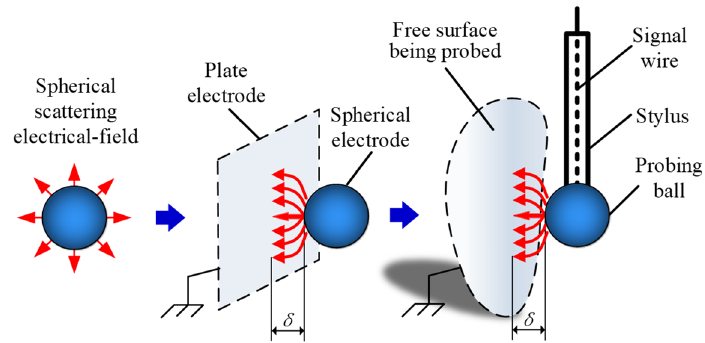
Figure 1. Working principle of spherical scattering electrical field probe (SSEP).